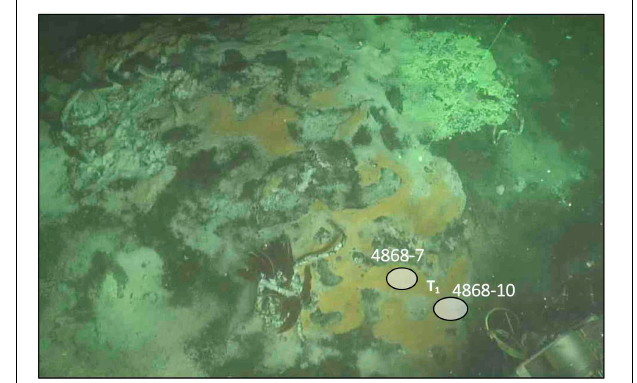
FIGURE 1 | Hydrothermal sediments with white, yellow and orange sulfur-oxidizing microbial mats ( Beggiatoaceae ), sulfur precipitates, and Riftia tubeworm colonies at Mat Mound Massif (111 ◦ 24.57’W/27 ◦ 00.40’N). The DGGE core 4868-7 and the porewater geochemistry core 4868-10 were collected next to the temperature profile measured using the Alvin heatflow probe ( Supplementary Table 1 ). The two green laser dots in the center of the image above the coring sites mark a distance of 10 cm. Image obtained from Alvin framegrabber,